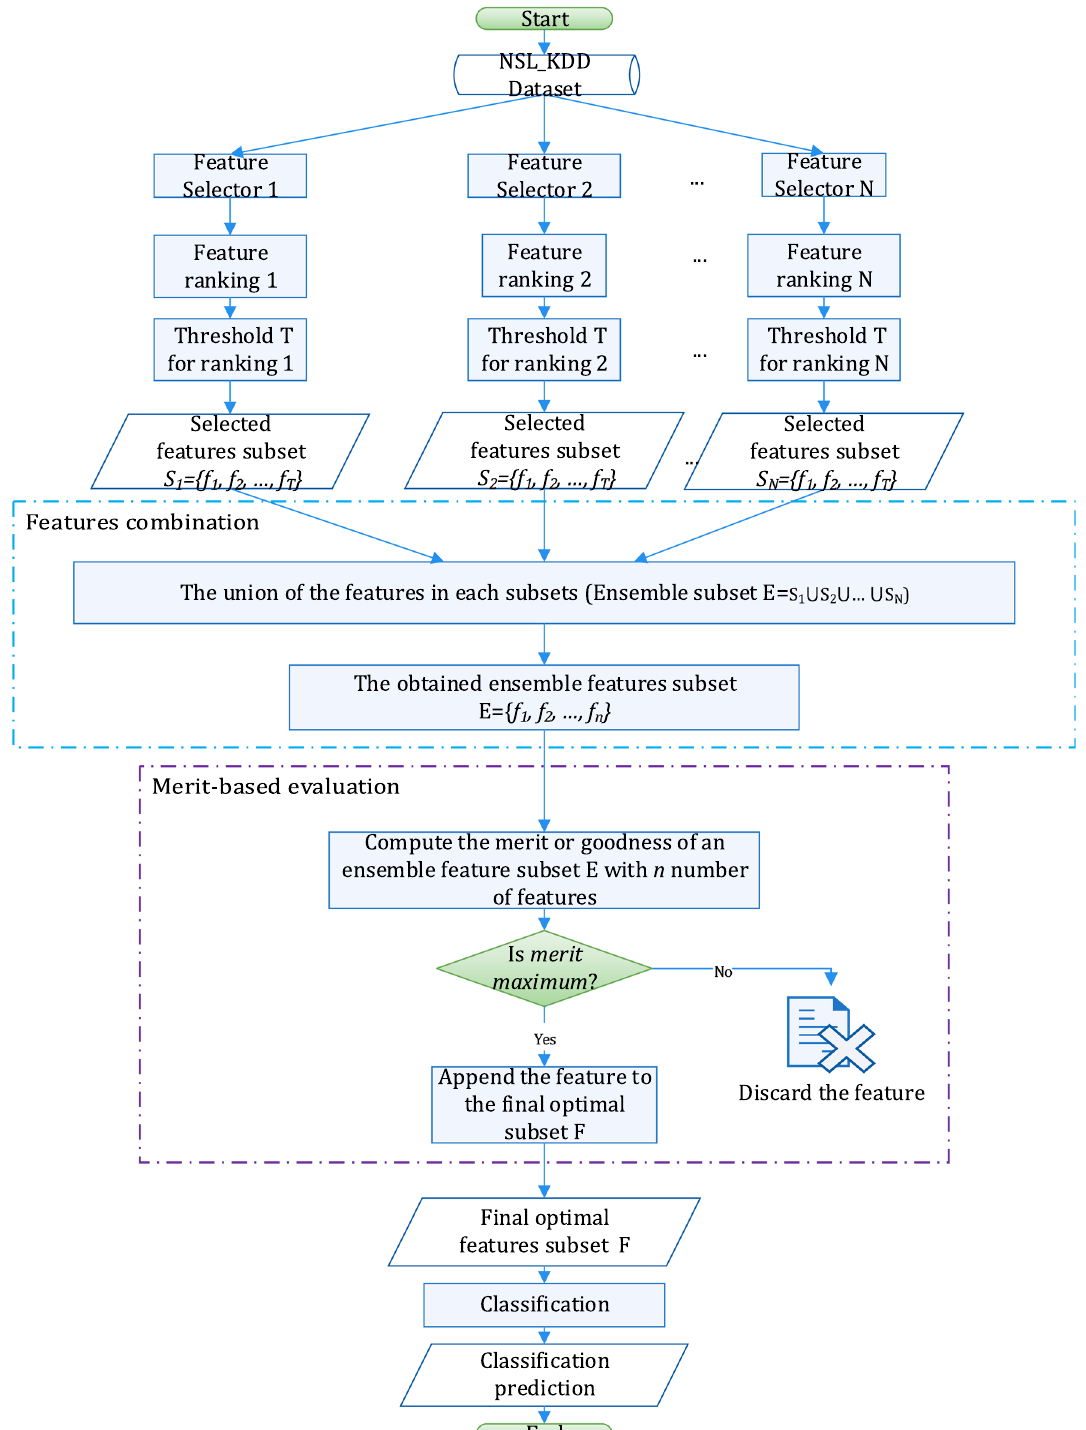
Fig. 2 The framework of the proposed